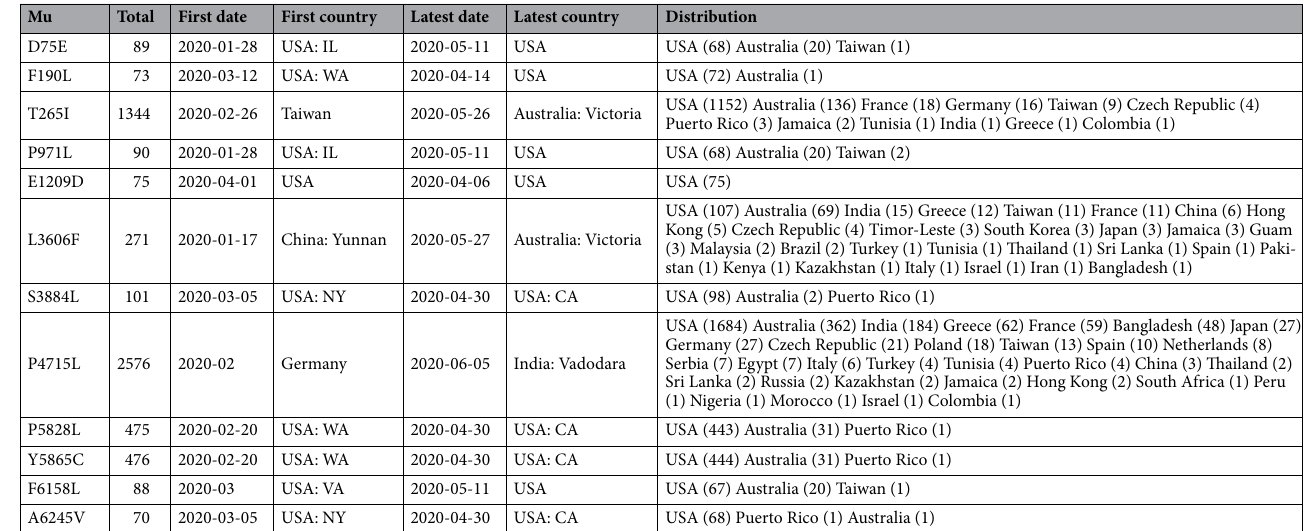
Table 3. Gene ORF1ab—nonsynonymous mutations occurring in 50 or more sequences.